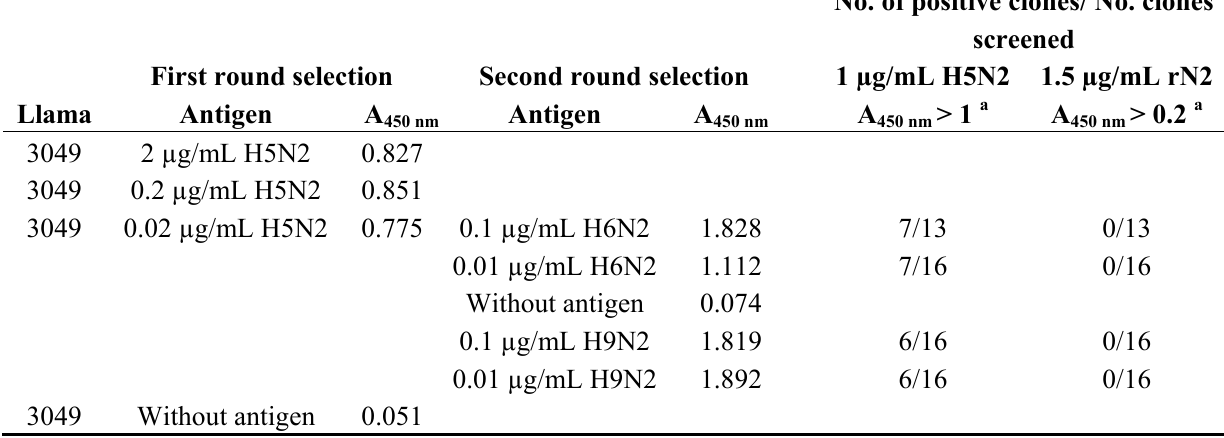
Table 1. Phage display selection of N2 binding llama single-domain antibody fragments (VHHs) by alternating selection on N2 subtype strains. The second selection round was performed using a phage selected on 0.02 µg/mL of H5N2 virus. Viruses were always directly adsorbed to polystyrene plates. Clones were screened for binding to the indicated antigens by incubation with E. coli -produced soluble VHH.